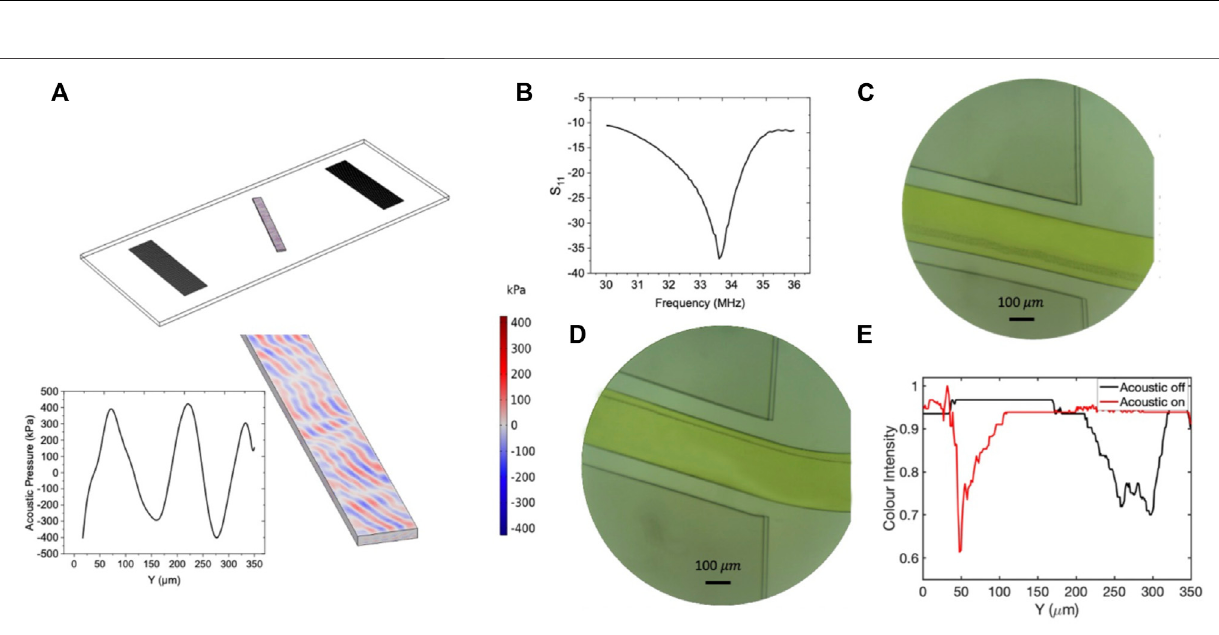
the channel and have not kept their slanted shape. By rising the voltage, the concentration of the particles moving to the middle of the channel increases; however, part of the particles are still located in parallel lines to the channel